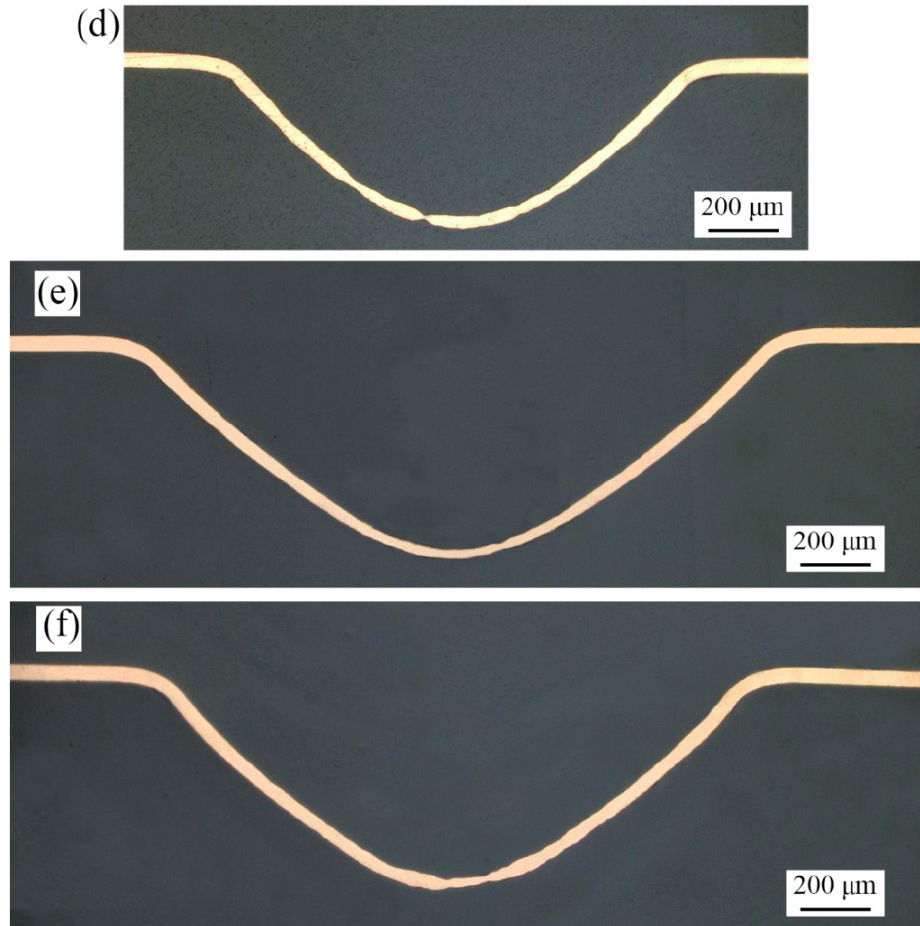
Figure 9. Section morphologies of bulging samples under laser pulse energy of 447 mJ. ( a ) λ = 0.25, fine-grained samples; ( b ) λ = 0.25, coarse-grained samples; ( c ) λ = 0.5, fine-grained samples; ( d ) λ = 0.5, coarse-grained samples; ( e ) λ = 1, fine-grained samples; ( f ) λ = 1, coarse-grained samples.